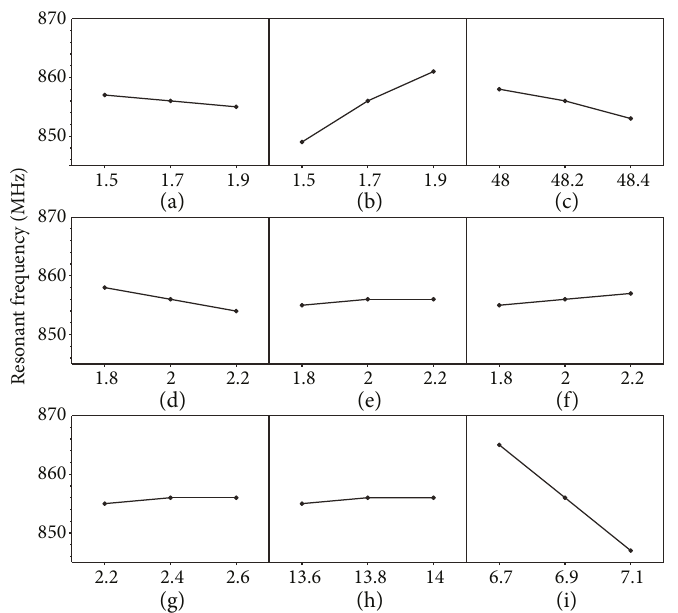
1 , (b) g 2 , (c) l 1 , (d) l 2 , (e) w 1 , (f) w 2 ,